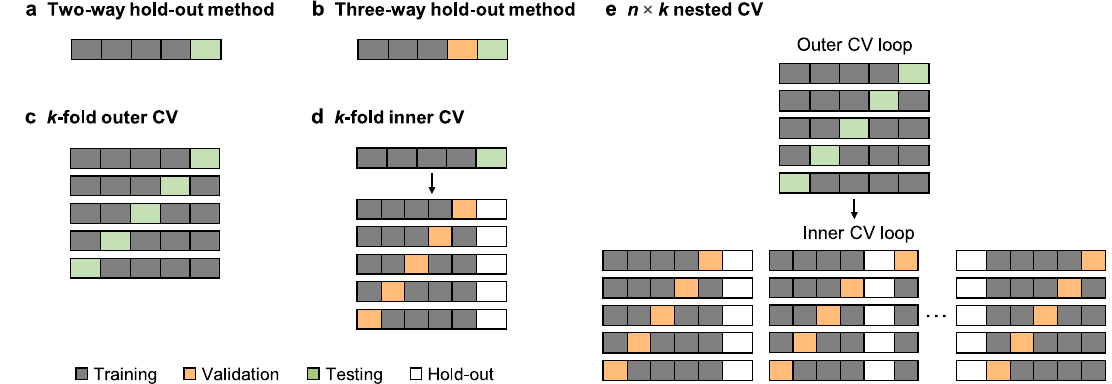
Fig. 6 Common validation approaches. a Two-way hold-out method (a single split of the whole dataset into training and testing sets). b Three-way hold-out method (a single split of the whole dataset into training, validation, and testing sets). c k -fold outer cross-validation (CV; on the whole dataset). d k -fold inner CV (a single split of the whole dataset into training and testing sets, followed by CV on the training set). e n × k nested CV with n -fold outer CV loops each containing k -fold inner CV. For illustration purposes, an 80/20 split was showcased in methods ( a ) and ( d ) for the training/testing split; a 60/20/20 split was showcased in method ( b ) for the training/validation/testing split; and both n and k were set as 5 for CV approaches. Note that methods ( a ) and ( c ) are merely used for model evaluation, while the remaining methods can be adopted for both model selection and model